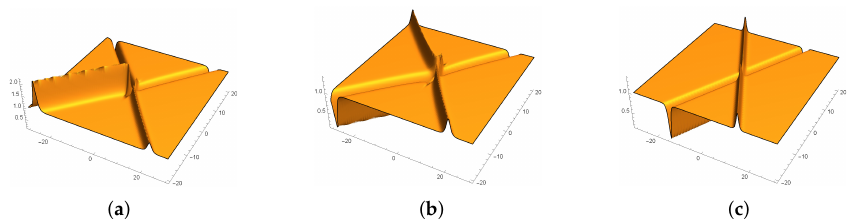
Figure 3. Elastic interactions via the solution (19a): ( a ) dark and antidark solitons with ρ = 1, λ 1 = 0.4 i , c ( z ) = z and γ 1 = 2 − 0.5 i ; ( b ) dark and antidark solitons with ρ = 1, λ 1 = 0.4 i , c ( z ) = z 2 and γ 1 = 2 − 0.5 i ; ( c ) dark and antidark solitons with ρ = 1, λ 1 = 0.4 i , c ( z ) = e z and γ 1 = 2 − 0.5 i .